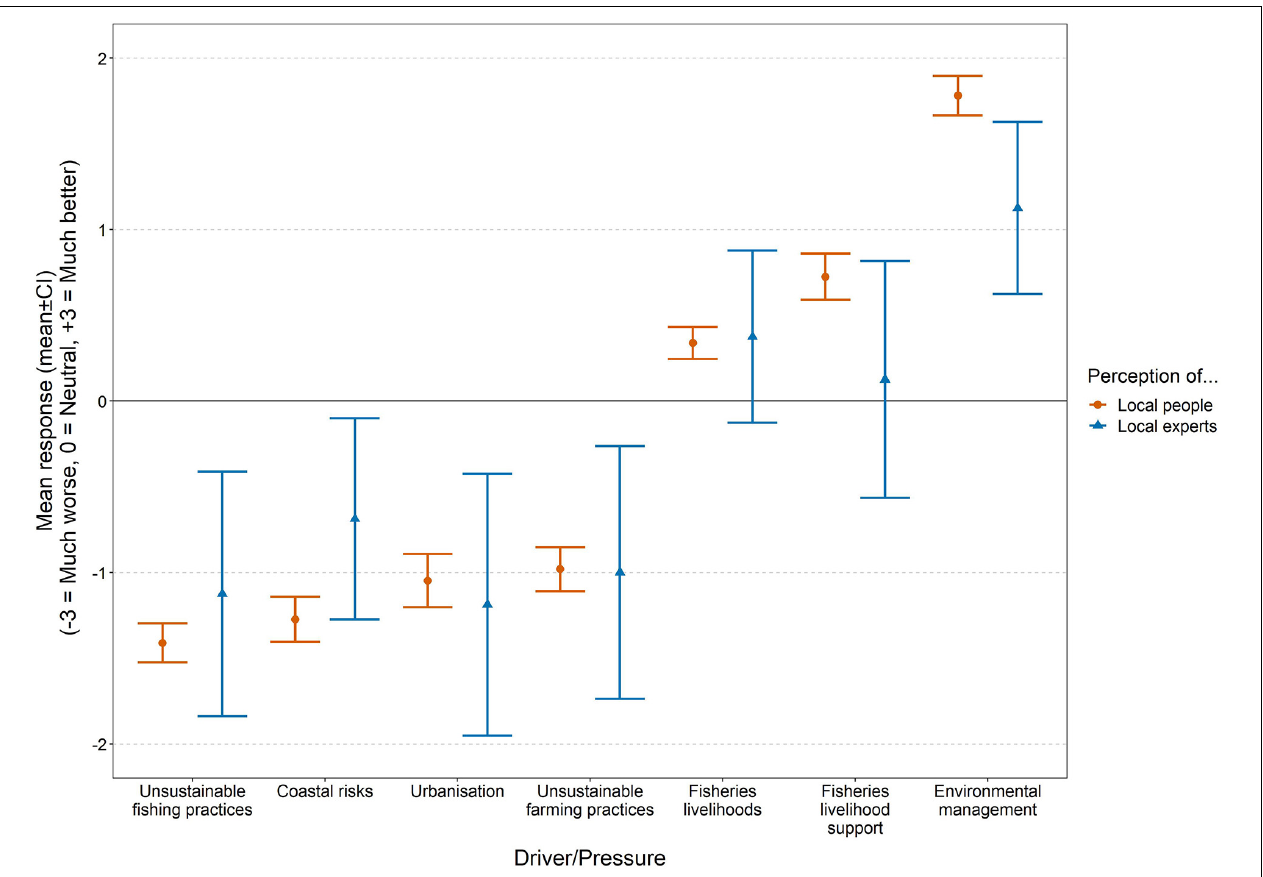
FIGURE 2 | Mean scores ( ± 95% Confidence Intervals) of local people ( n = 431, orange circle) and experts ( n = 16, blue triangle) for the perceived drivers/pressures on the coastal marine environment in Palawan,